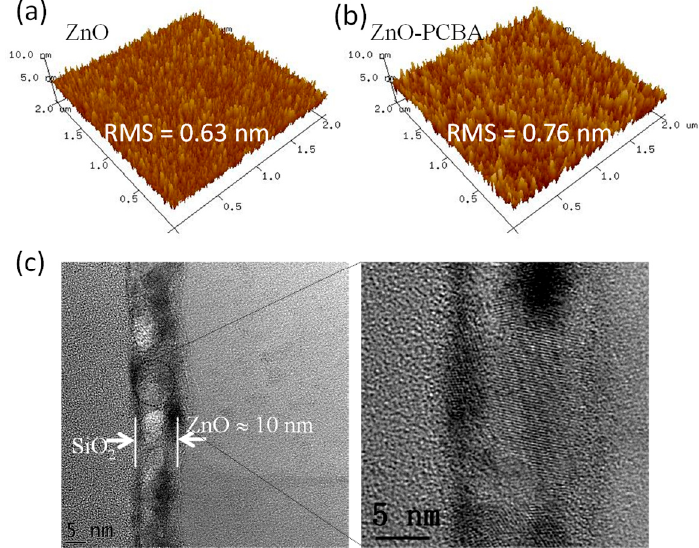
Figure 2. Atomic force microscopy (AFM) images of the pristine ZnO ( a ) and the ZnO with 4-chlorobenzoic acid (PCBA) interfacial modification layers ( b ). Cross-sectional high-resolution transmission electron microscopy (HR-TEM) images of the solution-processed ZnO films on the SiO 2 substrates ( c ).